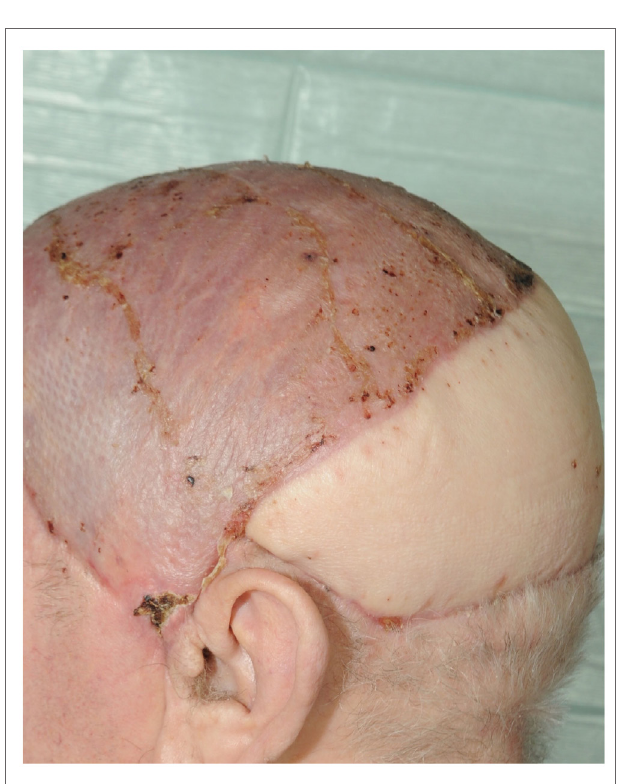
FiGURe 9 | Follow up after 4 weeks .